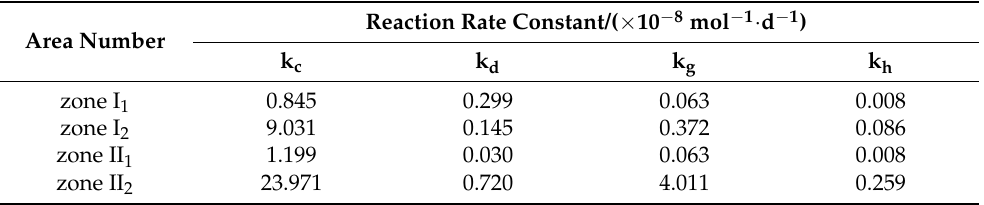
Table 1. Chemical reaction rate constant for each zone of the study area. Area